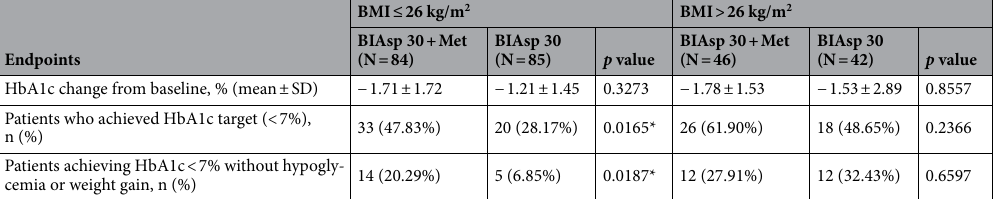
Table 3. The effect of body mass index (BMI) (≤ 26 kg/m 2 or > 26 kg/m 2 ) on efficacy outcomes in patients receiving biphasic insulin aspart 30 (BIAsp 30) and metformin combination therapy or BIAsp 30 monotherapy (ITT LOCF). BMI body mass index, ITT intention-to-treat, LOCF last observation carried forward, HbA1c glycated hemoglobin, SD standard deviation. * p <